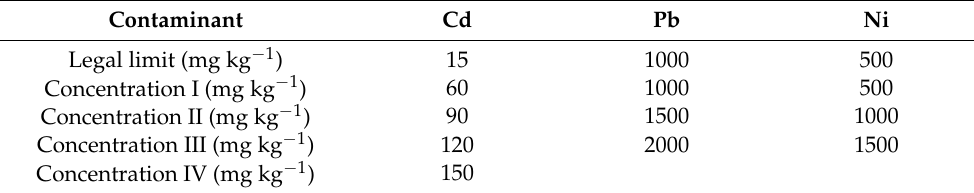
Table 1. Heavy metal concentration at the legal limit for commercial and industrial sites and the levels of contamination applied to the experimental